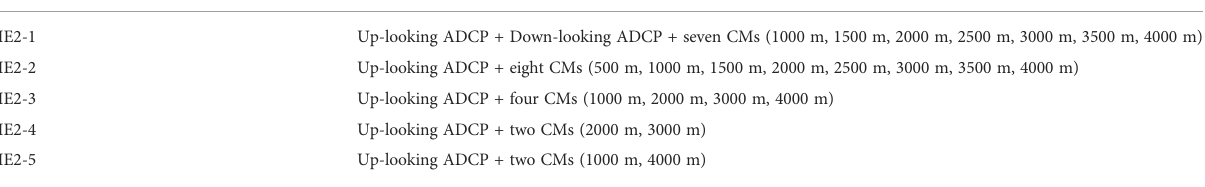
TABLE 4 Details of IEs at the mooring MP3.